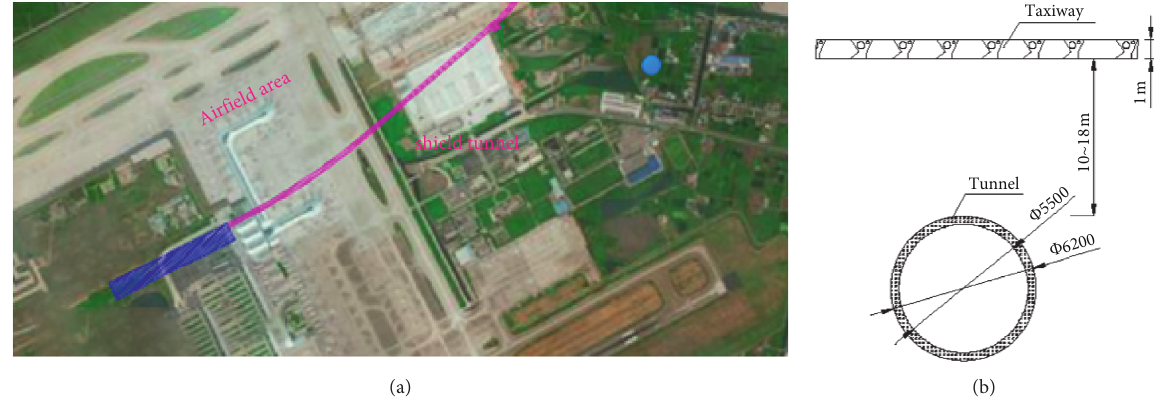
Figure 1: Location relationship between the shield tunnel and airport taxiway. (a) Plan. (b) Section.